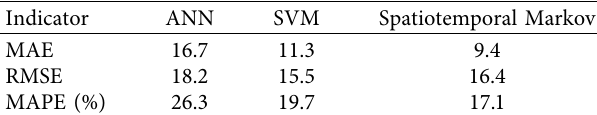
Table 2: Algorithms comparison